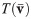
Reprinted from [Fig 9] under a CC BY license, with permission from [SUTC], original copyright [2018].Distribution of total system travel time in Lasa. Fig 9 (A) displays T(v¯) without tolls (h), and Fig 9 (B) displays T(v^) with differentiable tolls (h).